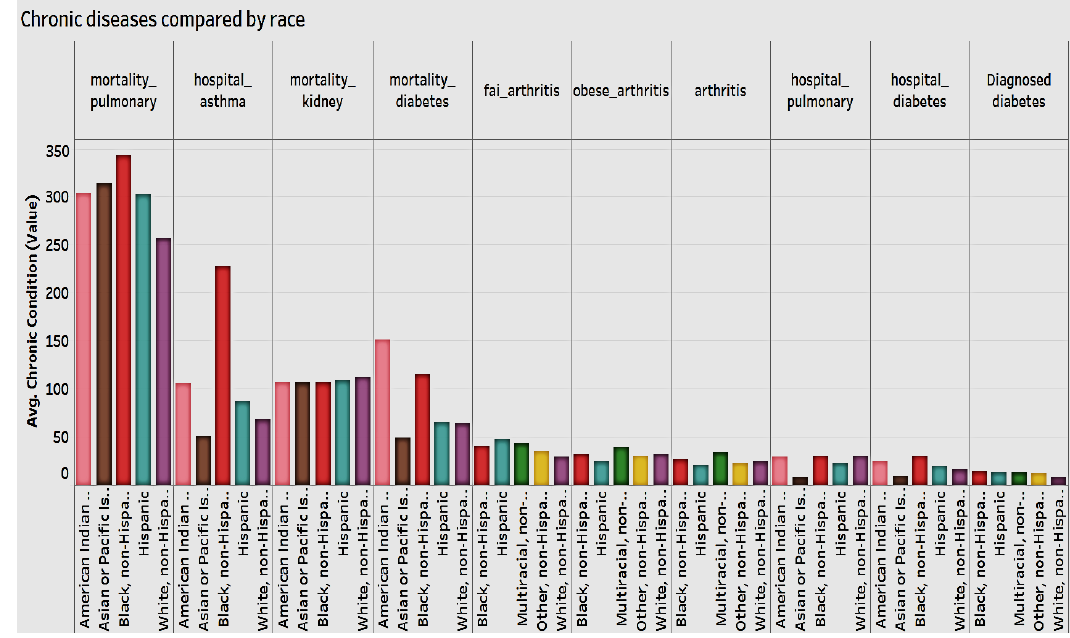
Figure 6. Chronic condition by gender.